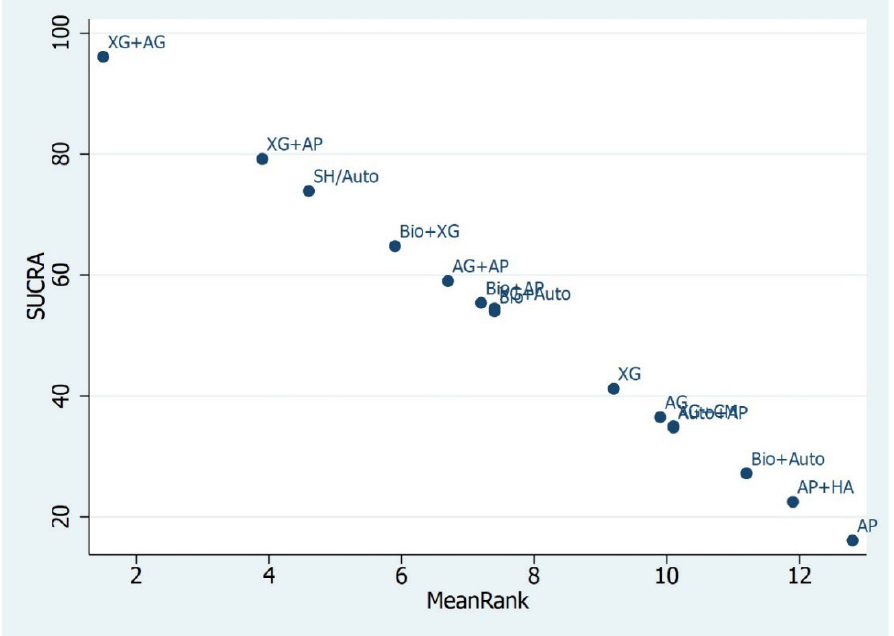
Figure 4. SUCRA Ranking for <4 mm RBH. XG+AG biomaterial was ranked highest among all the biomaterials compared and performed best in terms of clinical outcome. Alloplast performed worst when compared with other biomaterials in terms of clinical outcomes.